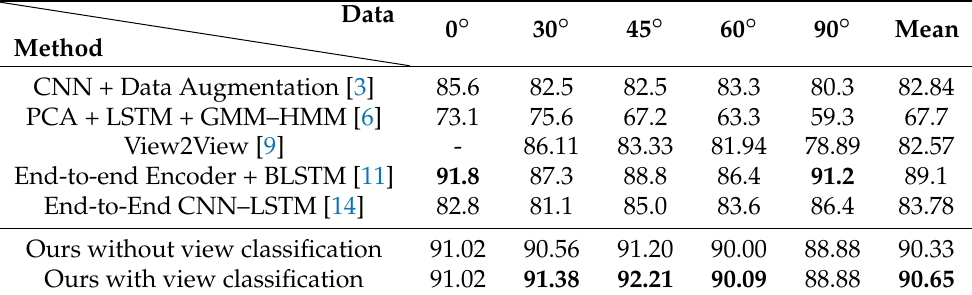
Table 4. VSR accuracy (%) of our proposed method and conventional